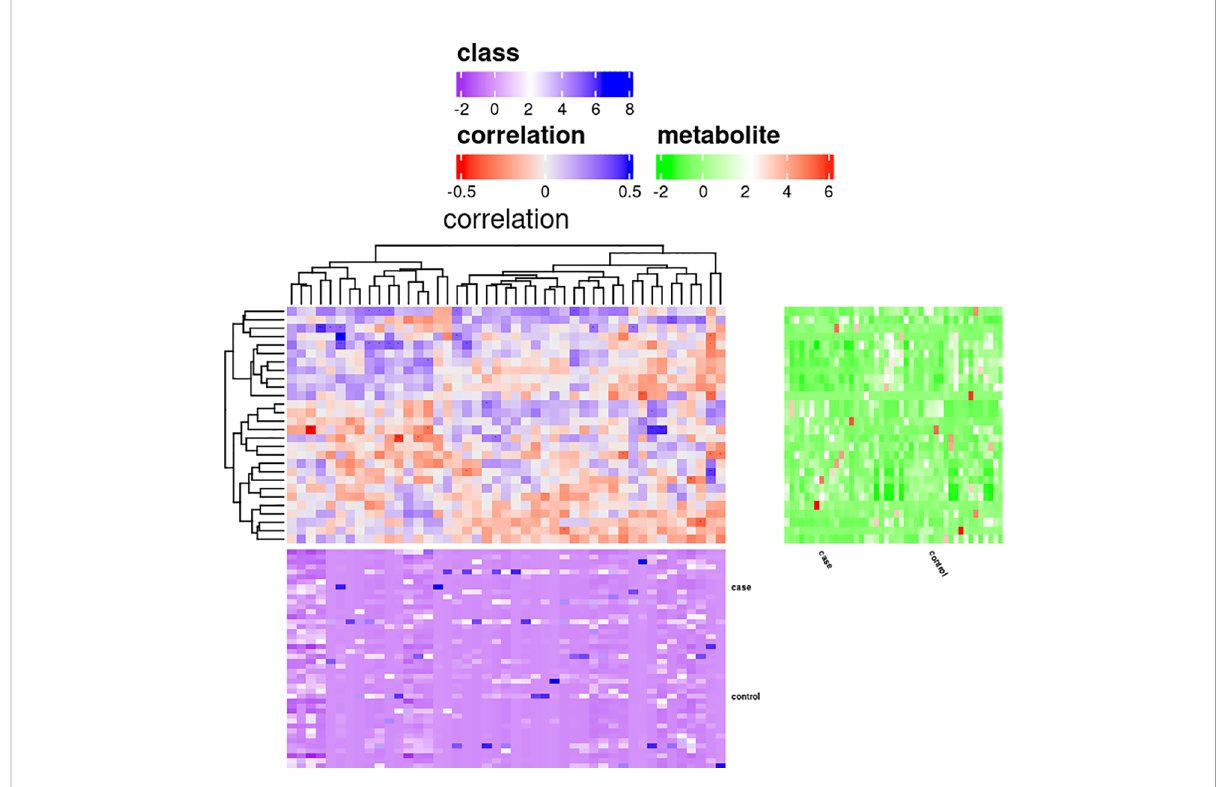
FIGURE 4 Correlation analysis of differential metabolites and